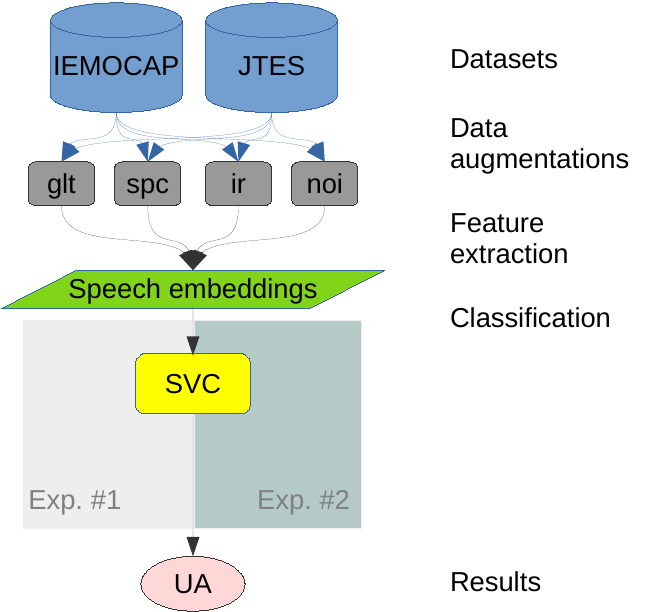
Figure 4. Flowchart of the main methodology from datasets to unweighted accuracy